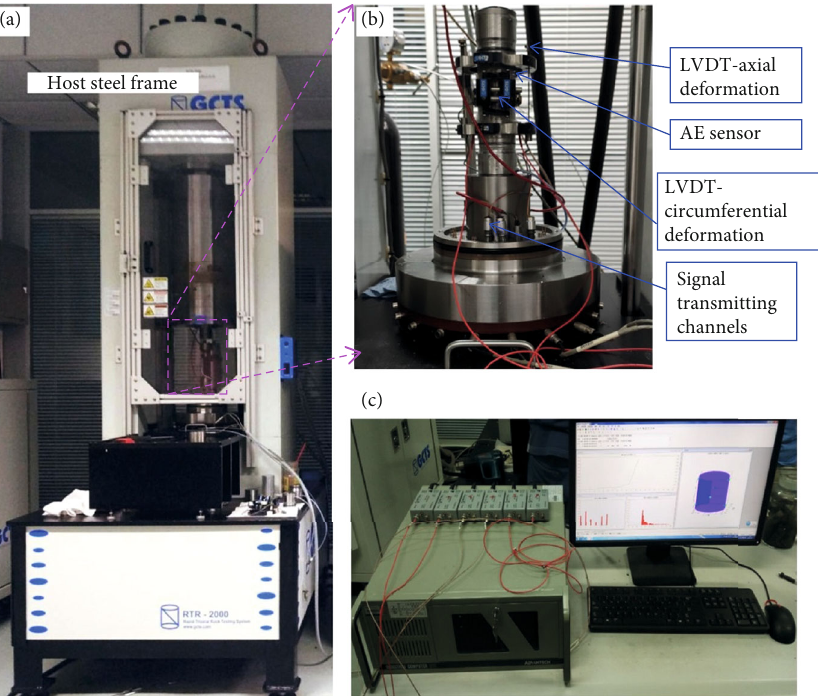
Figure 2: Testing system for the pre fl awed granite samples: (a) GCTS RTR 2000 rock mechanics machine; (b) LVDT system; (c) PAC-AE system. Table 1: Rock loading path description in the cyclic loading